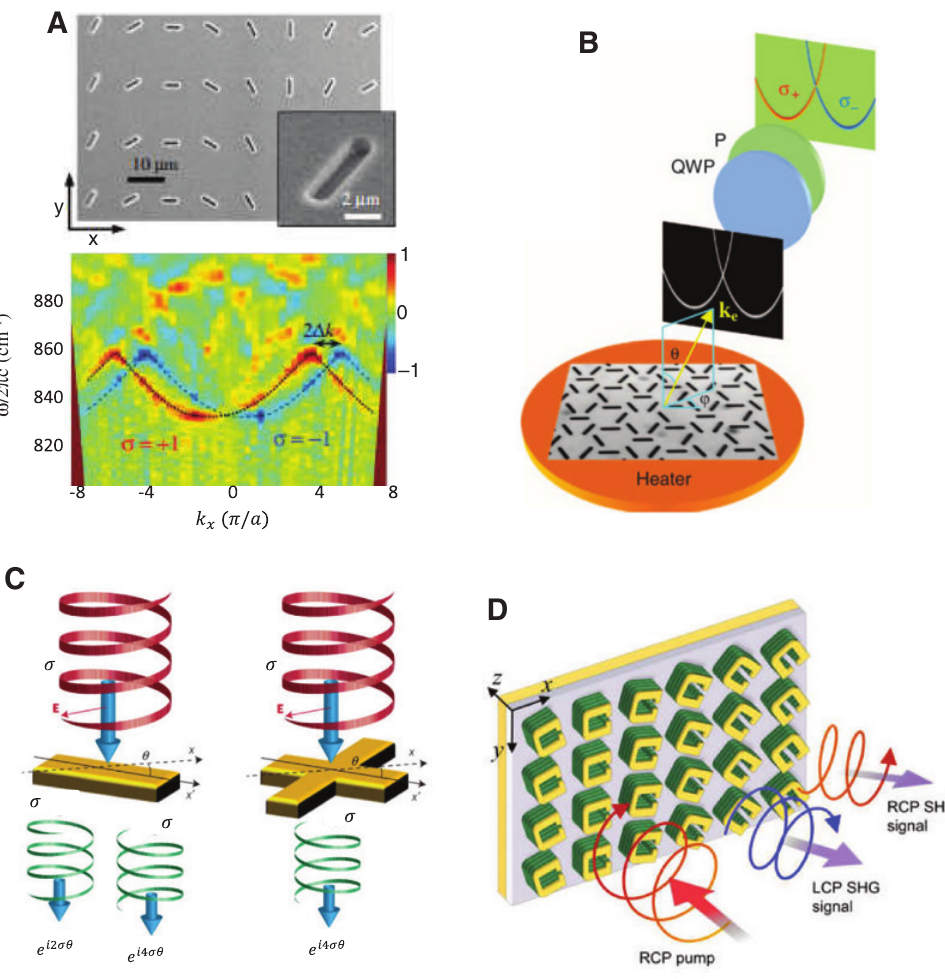
Figure 12: Symmetry effect with spin-orbit interaction. (A) Spin-split dispersion relation measured by S Stokes parameter of thermal radiation from the rotating slits in one dimension. Reprinted 3 from Ref. [108]. (B) Schematic set-up for the spin-projected dispersion based on 2D Rashba-like metasurface. Reprinted from Ref. [110]. (C) Metasurfaces with two- and four-fold symmetry allows strong third harmonic generation [141]. (D) Geometric-phase profile in selecting the outgoing angle of the second harmonic